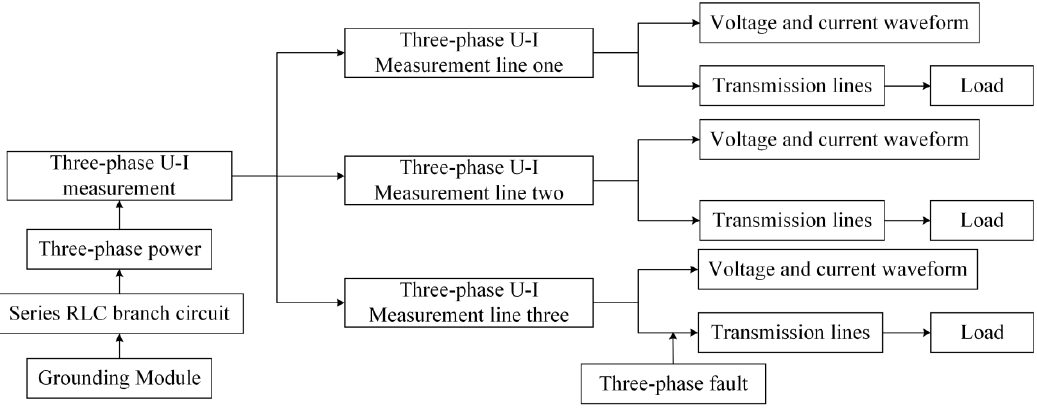
Figure 4. Schematic diagram of the simulation model.